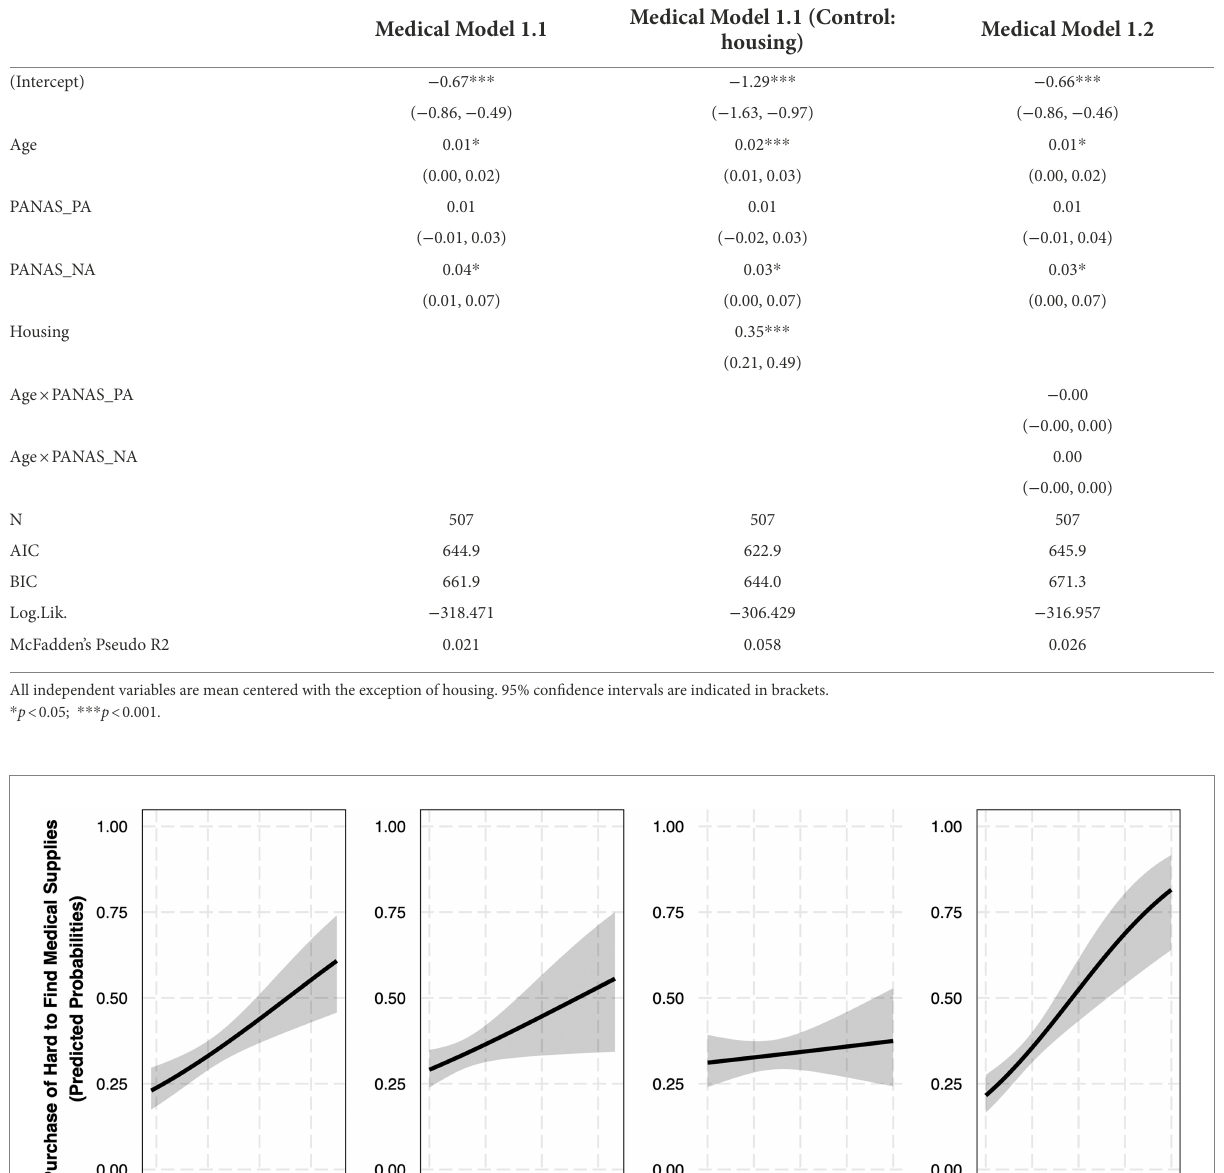
model was fit using age, PANAS_PA, and PANAS_NA as independent variables (Medical Model 1.1, Table 6). This model fit significantly better than the null model, X 2 (3) = 13.89, p = 0.003. Similar to the purchase of hard-to-find goods models, we suspected that age may interact with affect. As a result, we fit Medical Model 1.2 with two additional interaction terms (i.e., age * PANAS_NA and age *